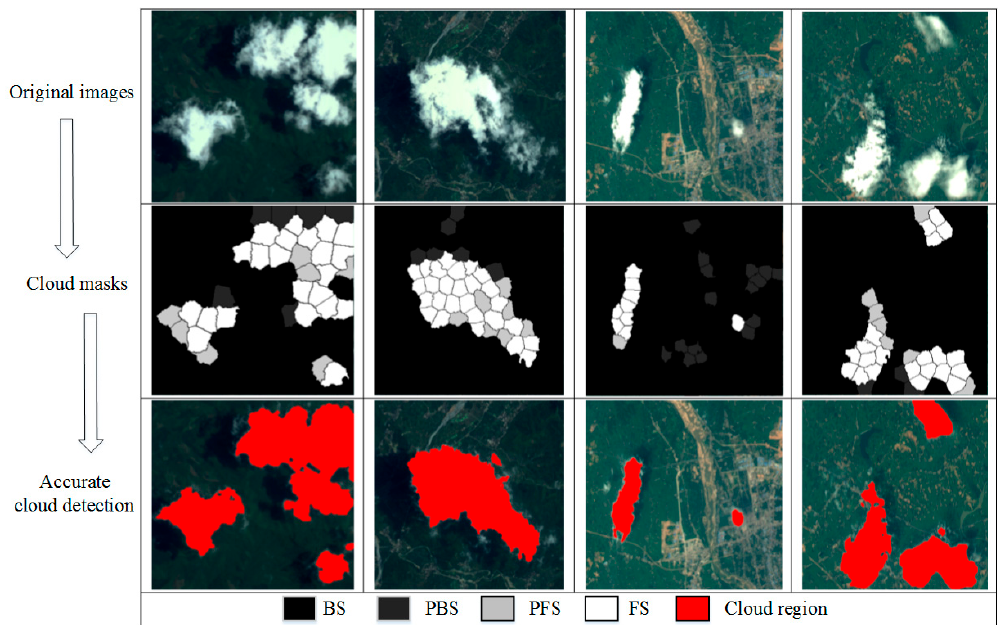
Figure 12. Example of accurate cloud detection by the proposed method. The first row shows the original images, the second row shows the cloud mask extracted by the method described in Section 3.2., and the third row shows the accurate cloud detection results